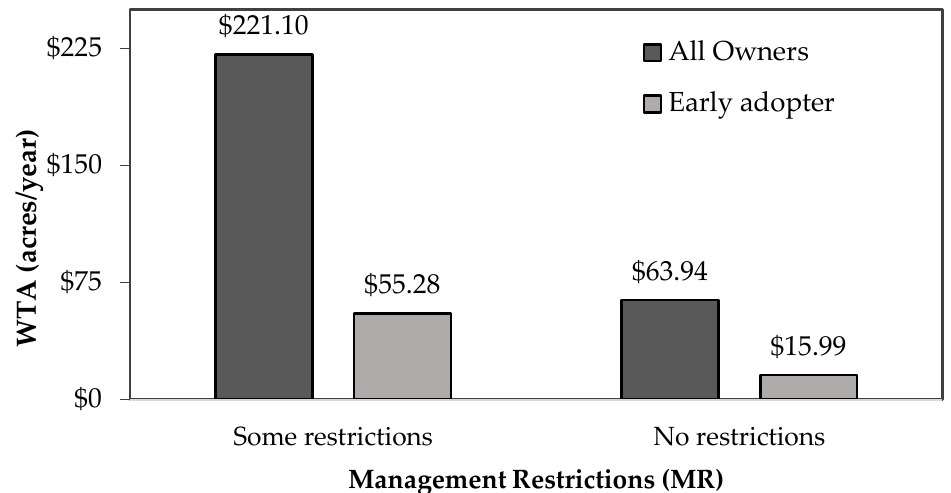
Figure 4. Willingness to accept payment for forest carbon if a delay in harvest is required (acre/year).